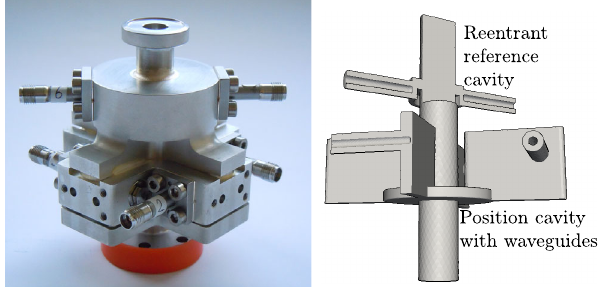
FIG. 3. Image of the cavity BPM pickup assembly (left) with the position cavity at the bottom and the reentrant reference cavity at the top and the vacuum geometry (right).